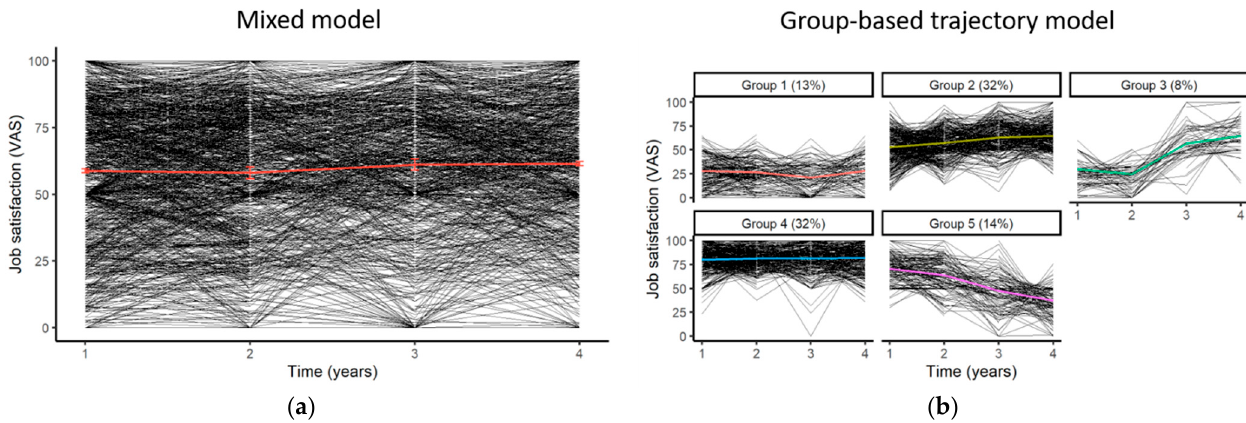
Figure 4. Evolutionary trajectories of job satisfaction among Wittyfit users: ( a ) mean trajectory using a mixed model (standard errors of coefficient are symbolized by error bars), ( b ) individual trajectories using a group-based trajectory model, where each group represent a possible evolution of the workers’ job satisfaction in the population (e.g., individuals belonging to “Group 3” are characterized by a slight decrease between times 1 and 2, then by a sharp increase beyond time 2).